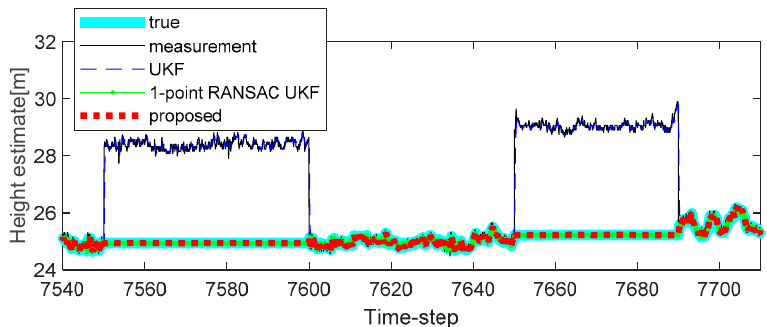
Figure 6. The second experimental results of height estimation with random bias type measurement errors in the second (7550 to 7600 time-step) and third period (7650 to 7690 time-step): case 2.